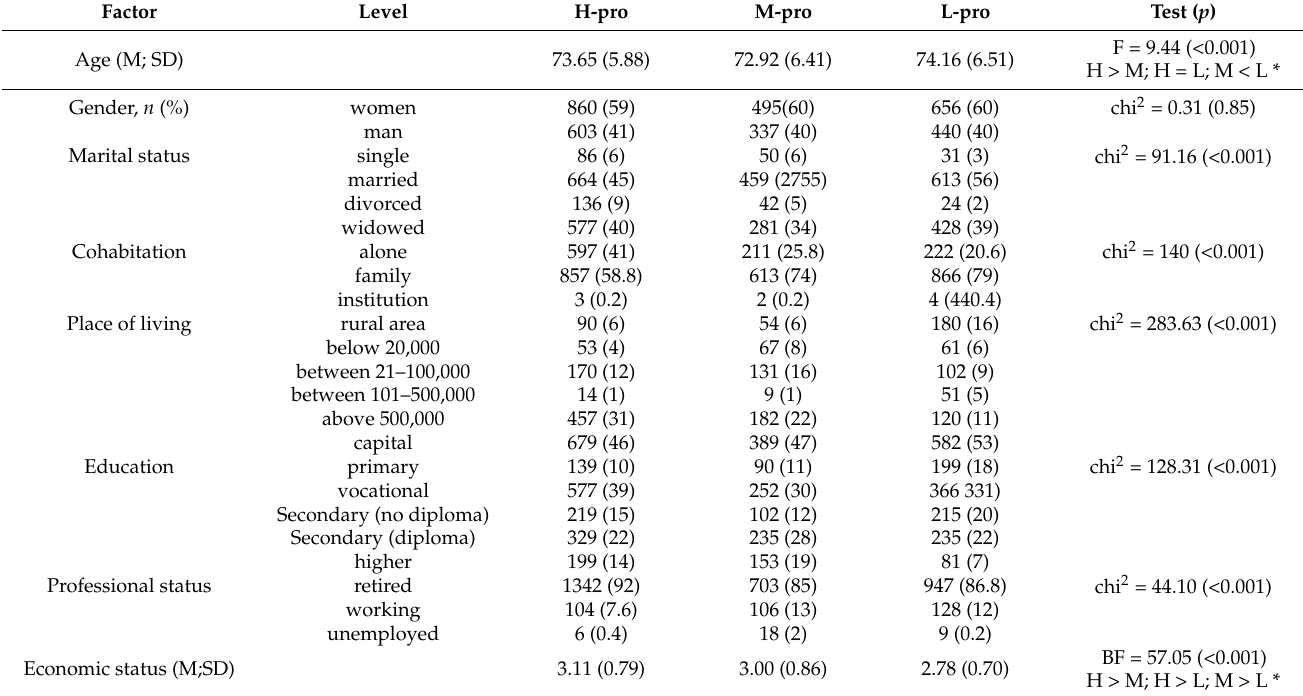
Table 1. The differences between health proactivity profiles according to sociodemographic factors.